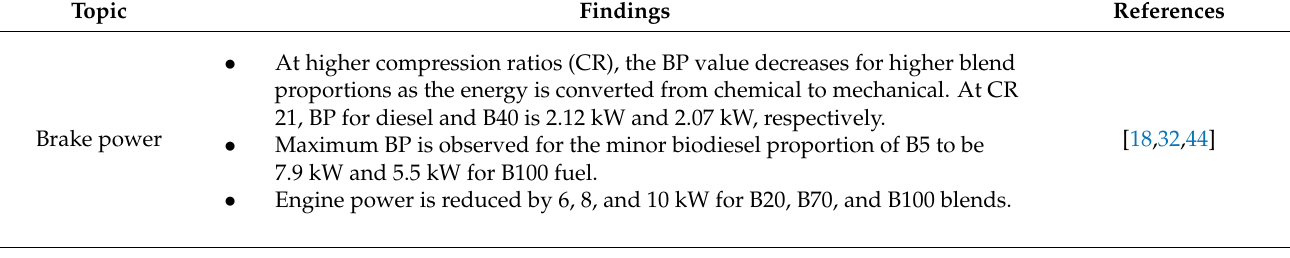
Table 4. Performance characteristics of waste cooking oil biodiesel blended with diesel fuel in diesel engines.